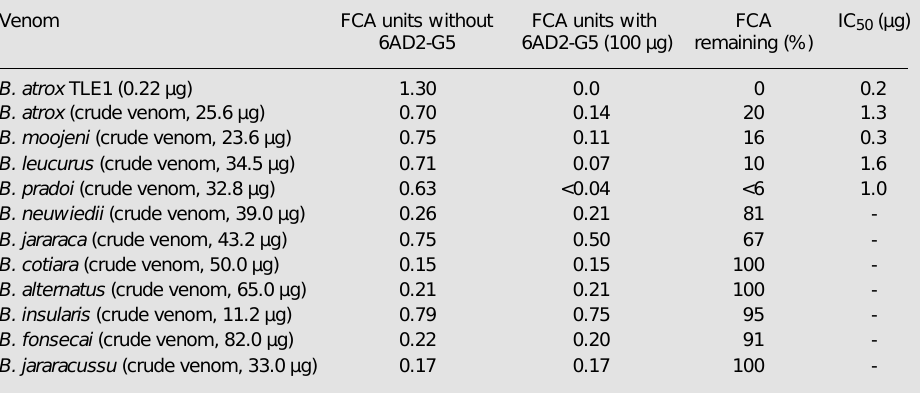
Table 4 - Inhibition of fibrinogen-clotting activity by mAb 6AD2-G5. The amount of venom or purified thrombin-like enzyme (TLE1) preparation used in the assay is given in parentheses. The fibrinogen-clotting activity (FCA) was measured as described in Material and Methods. Before addition of bovine fibrinogen solution, the venom or purified TLE1 was incubated with mAb 6AD2-G5 for 10 min at 37 o C. The IC 50 assay was performed with several concentrations of mAb 6AD2-G5 in order to estimate the mAb concentration necessary to inhibit 50% of the fibrinogen-clotting activity. Venom FCA units